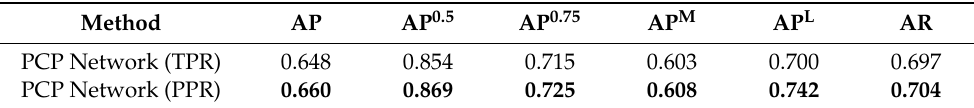
Table 2. Ablation study results: traditional pose representation (TPR) vs. proposed PPR on the COCO2017 val dataset. Superscripts M, L of AP stand for medium and large objects. The highest values are indicated in bold.